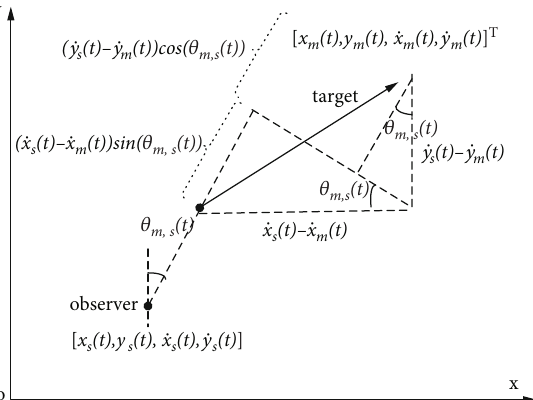
Figure 1: Multiple-target tracking scenario using Doppler and bearing measurement.